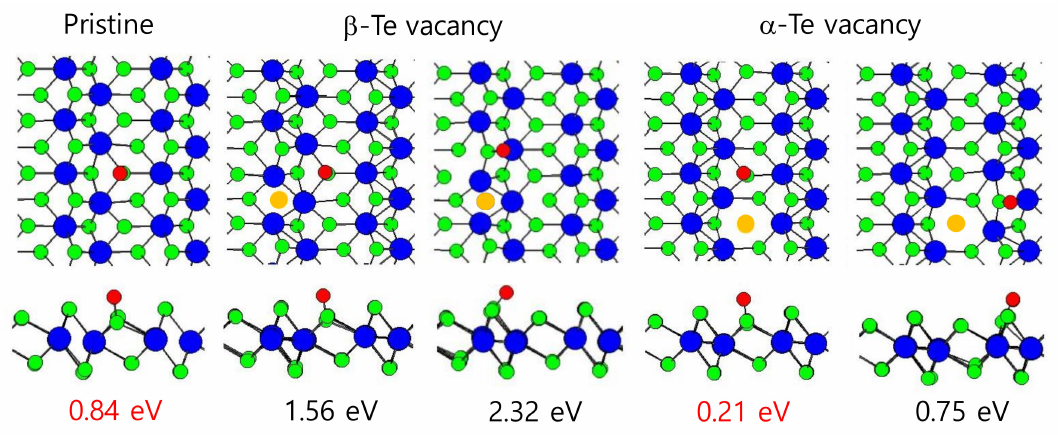
Figure 4. Hydrogen adsorption energies at α and β sites of TM Te 2 with or without Te